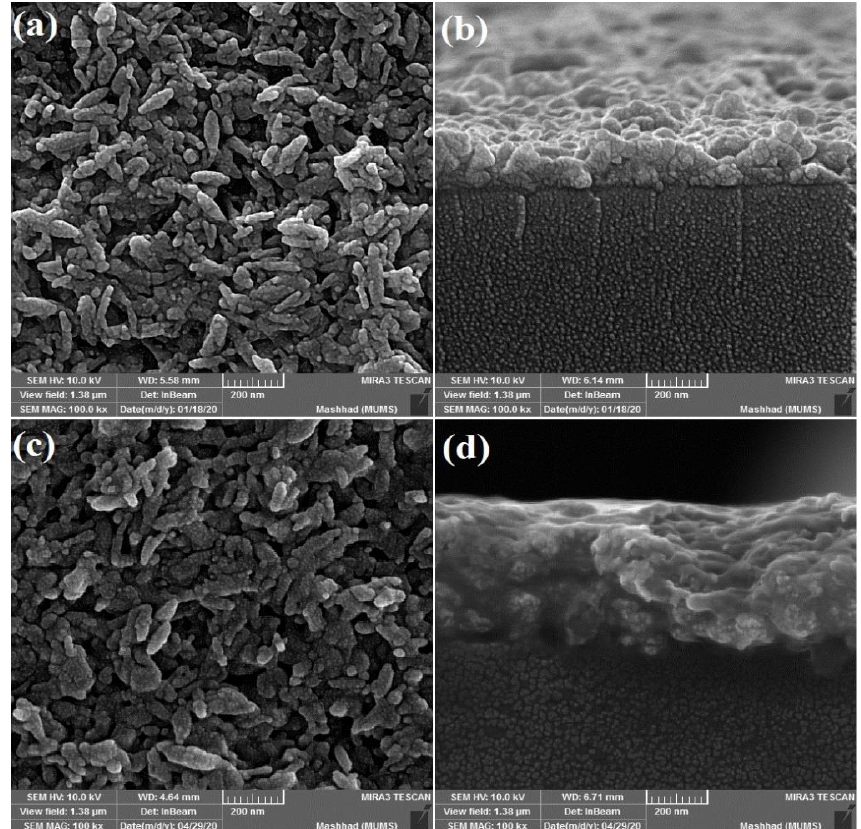
Figure 3. Field-Effect Scanning Electron Microscope Image of α-Fe 2 O 3 Thin Films, (a, b) prior to the plasma application and (c, d) following the plasma application. Figures b, d show the cross-section area of the